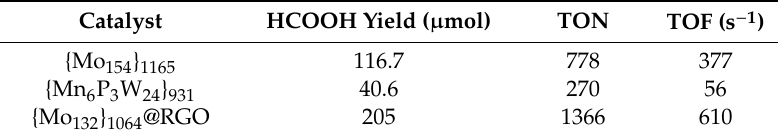
Table 3. The photocatalytic performance of the di ff erent catalysts